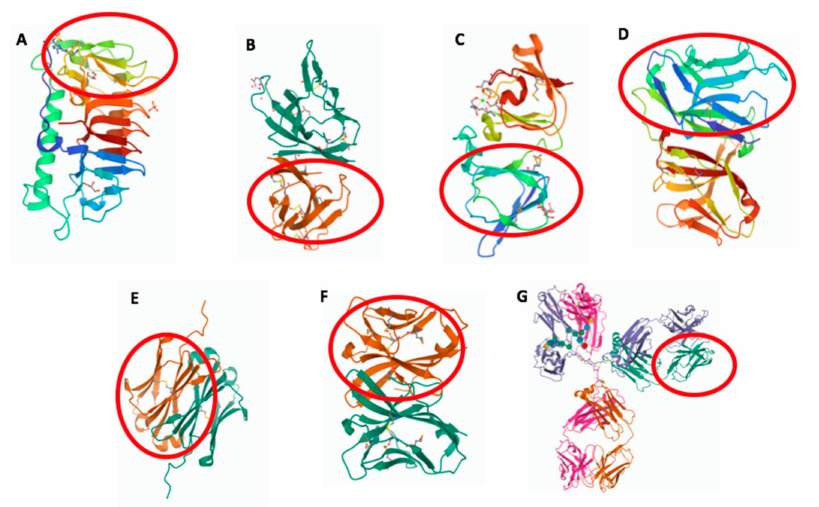
Figure 1. Three-dimensional structure of molecules from different species containing an IgV-like or IgV domain (in red circle). ( A ) Shewanella frigidimarina ice-binding protein_1, PDB entry: 6BG8; ( B ) SARS-CoV-2 ORF8, PDB entry: 7JX6; ( C ) Geodia cydonium geodin, PDB entry: 4IAU; ( D ) Branchios- toma floridae VCBP, PDB entry: FBO; ( E ) Ginglymostoma cirratum IgNAR V domain, PDB entry: 2I27; ( F ) Ictalurus punctatus NITR11, PDB entry: 2QQQ; and ( G ) Mus musculus IgG1, PDB entry: